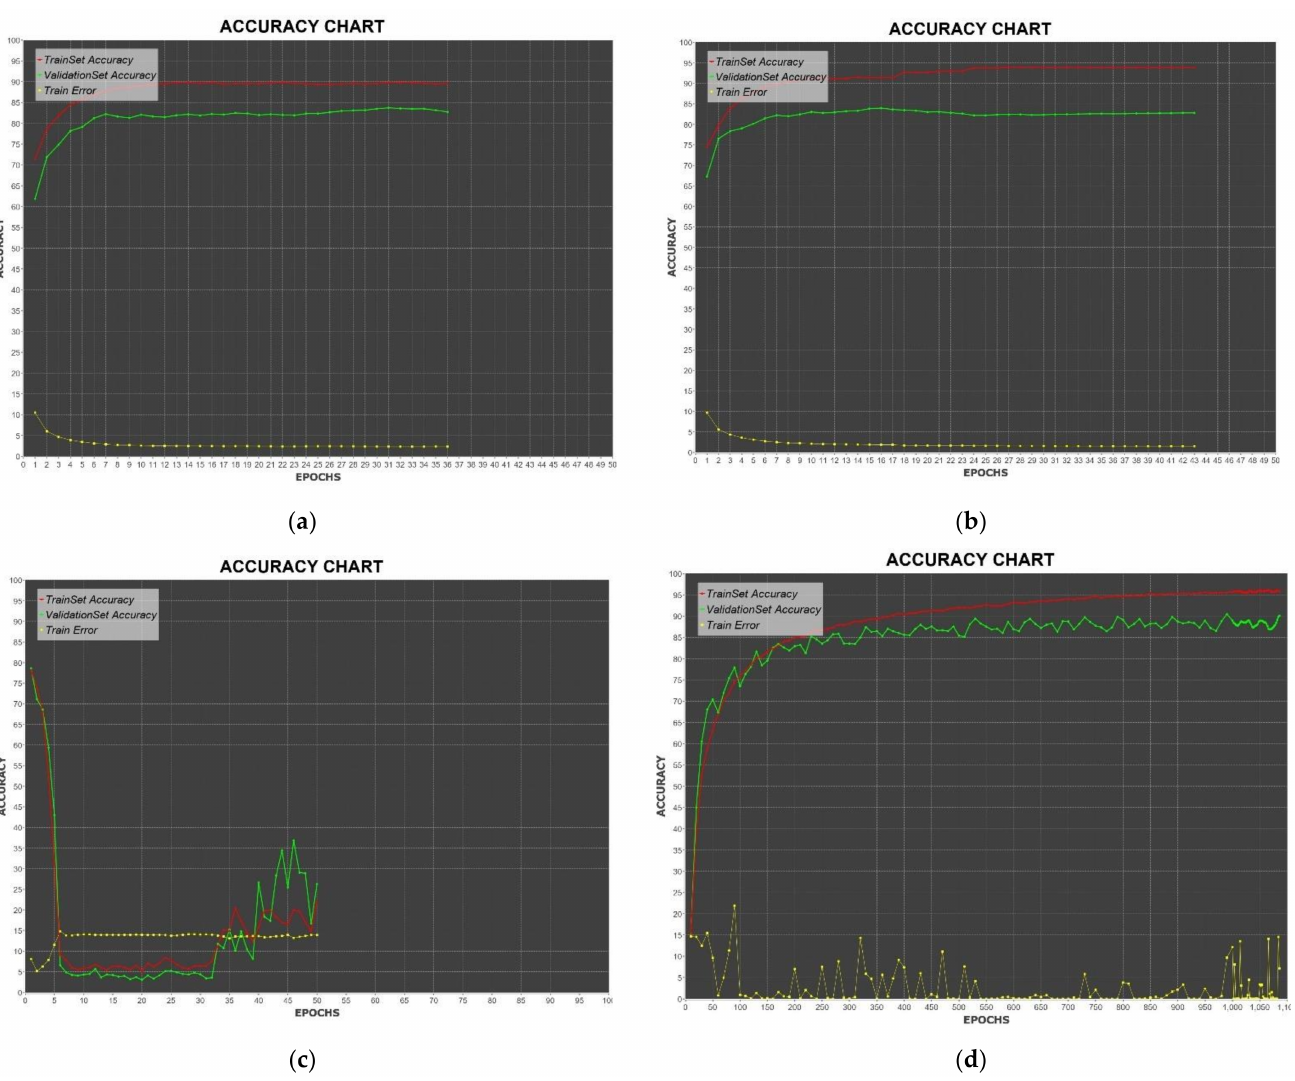
Figure 10. Comparison of activation functions. ( a ) Training with the logistic sigmoid function; ( b ) training with the Elliott function; ( c ) training with the ReLU function (backpropagation); ( d ) training with the ReLU function